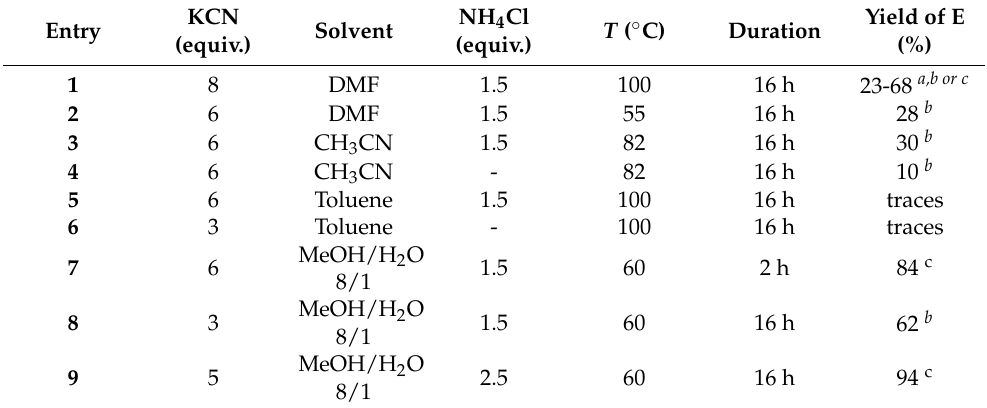
Table 1. Optimization of the nucleophilic opening of the epoxide F by potassium